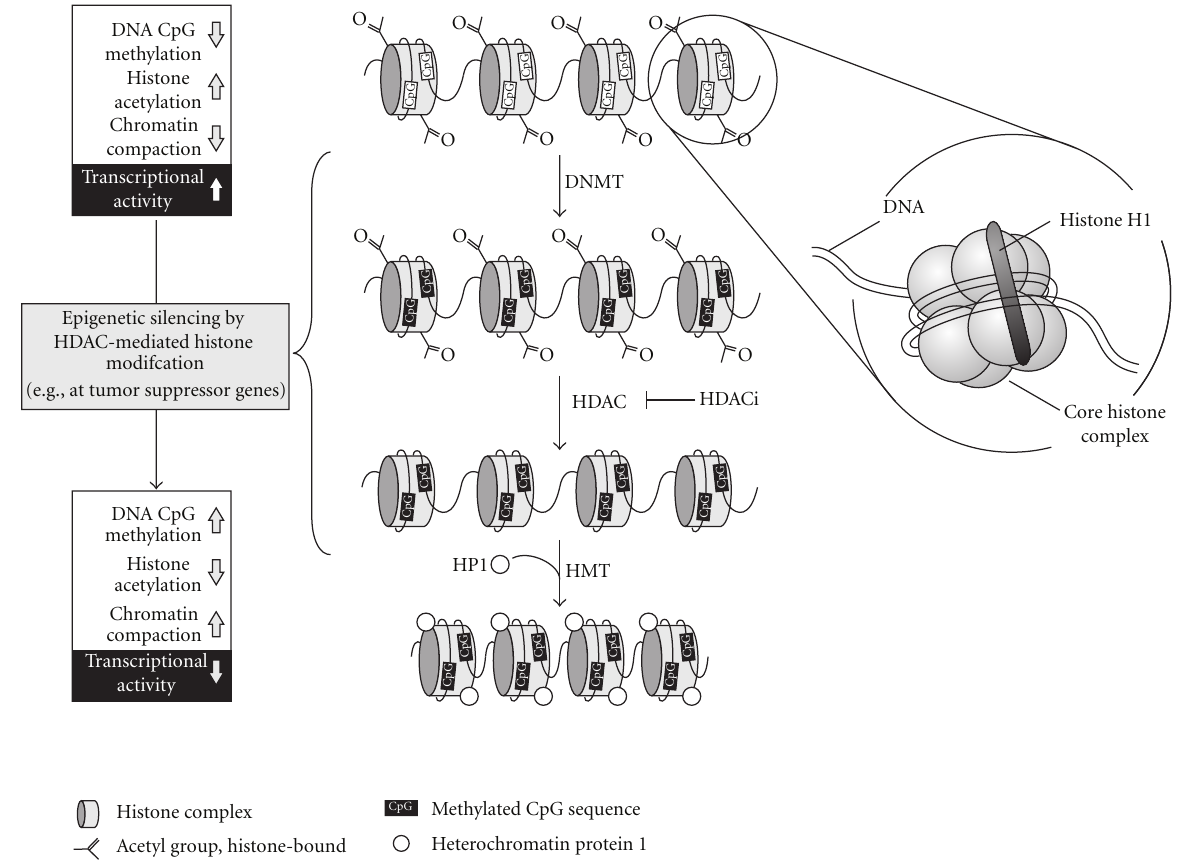
Figure 2: Overview of transcriptional regulation by epigenetic mechanisms involving DNA methylation and histone acetylation. Abbrevia- tions: DNMT: DNA methyl transferase; HDAC(i): histone deacetylase (inhibitor); HMT: histone methyltransferase; HP1: heterochromatin protein